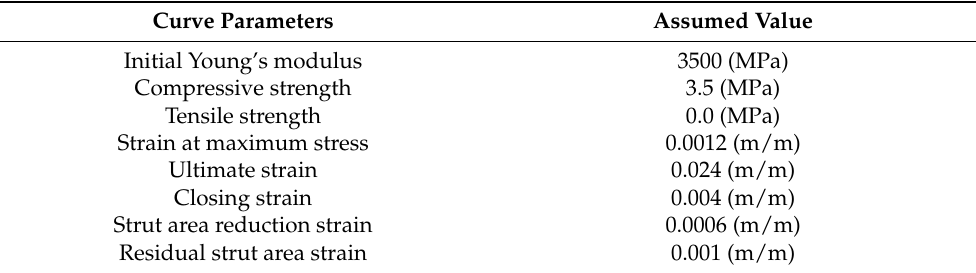
Table 2. Parameters of the compression strut implemented in the masonry model.